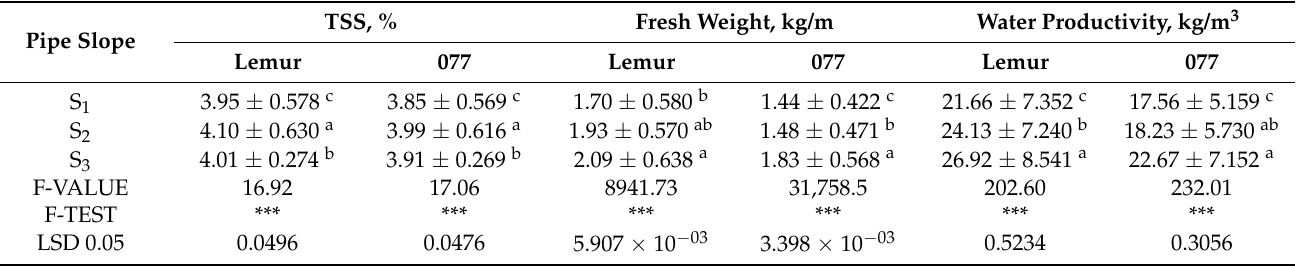
Table 4. Effect of pipe slope on total soluble solids (TSS), fresh weight (FW) and water productivity ( WP ) of both iceberg lettuce cultivars.